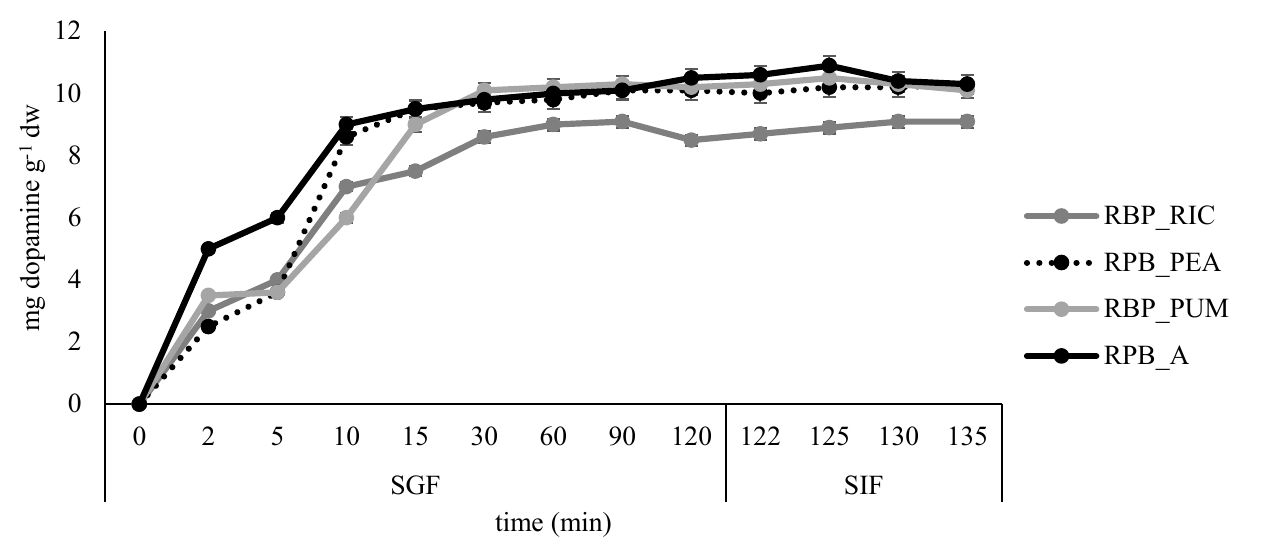
Figure 9. Release profile of dopamine in simulated gastro-intestinal digestion for the edible films prepared from banana peel extract.